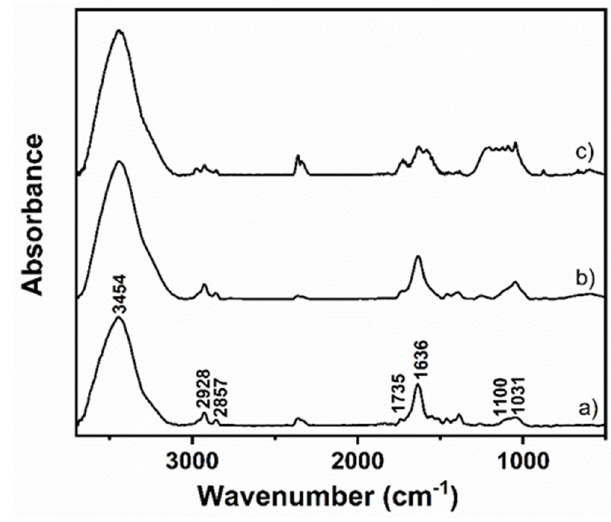
Figure 1. FTIR spectra of GO ( a ), rGO15 ( b ) and rGO30 ( c )